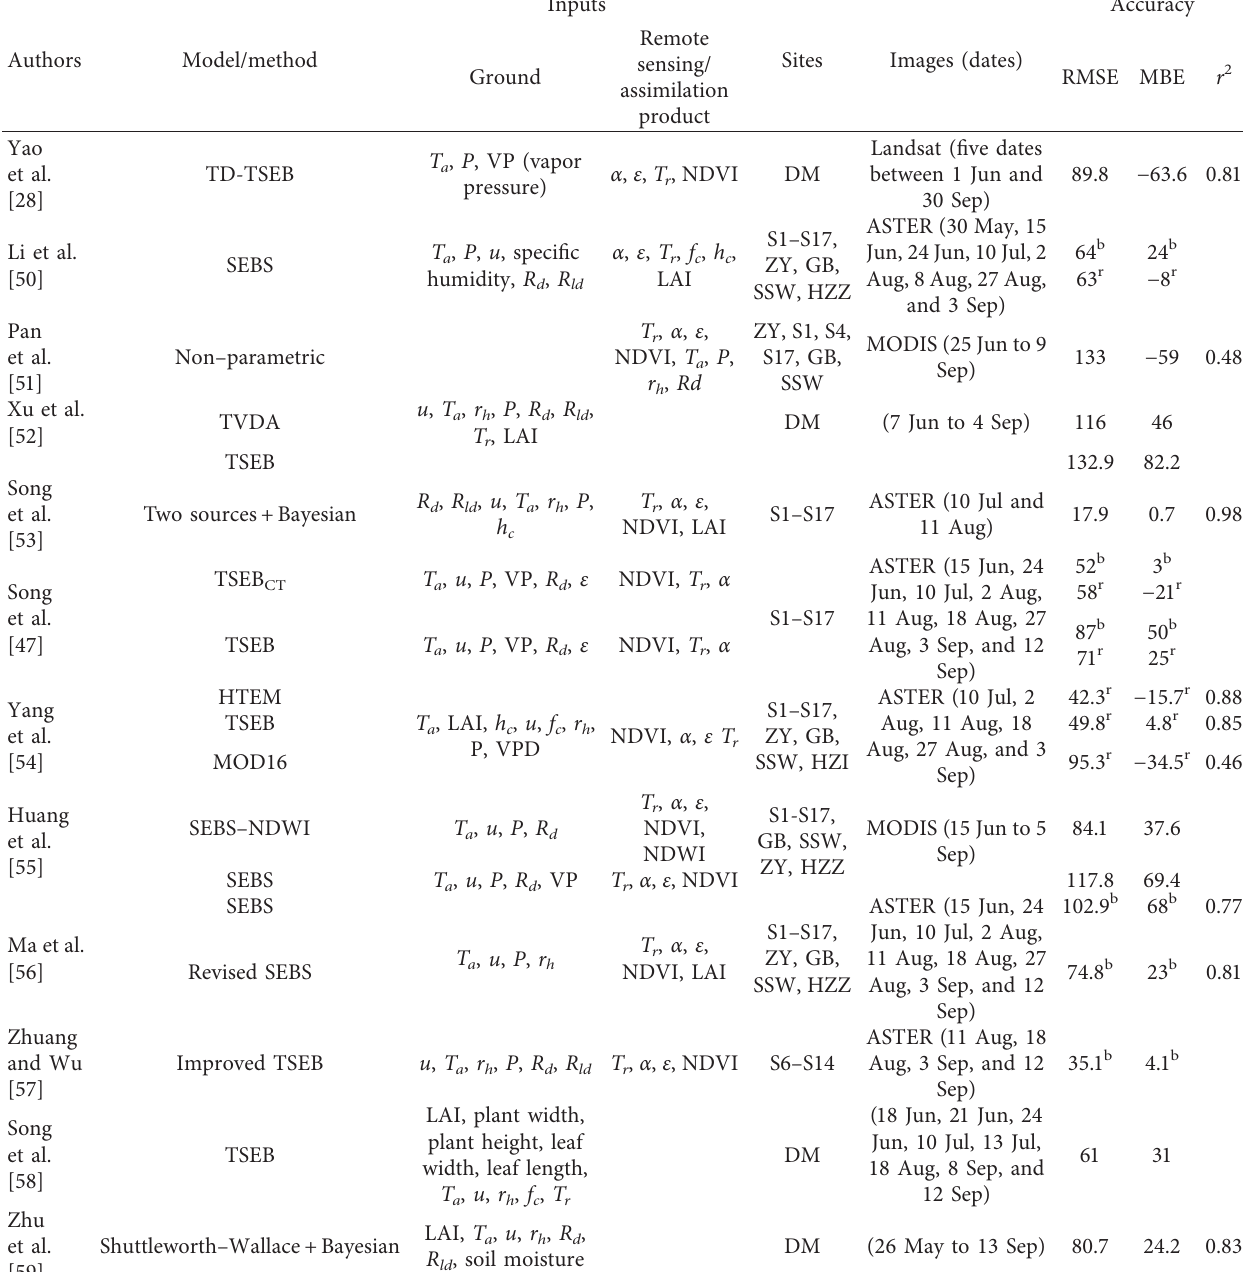
Table 3: Comparison of LE (W · m − 2 ) estimation accuracies using the HiWATER-MUSOEXE-12